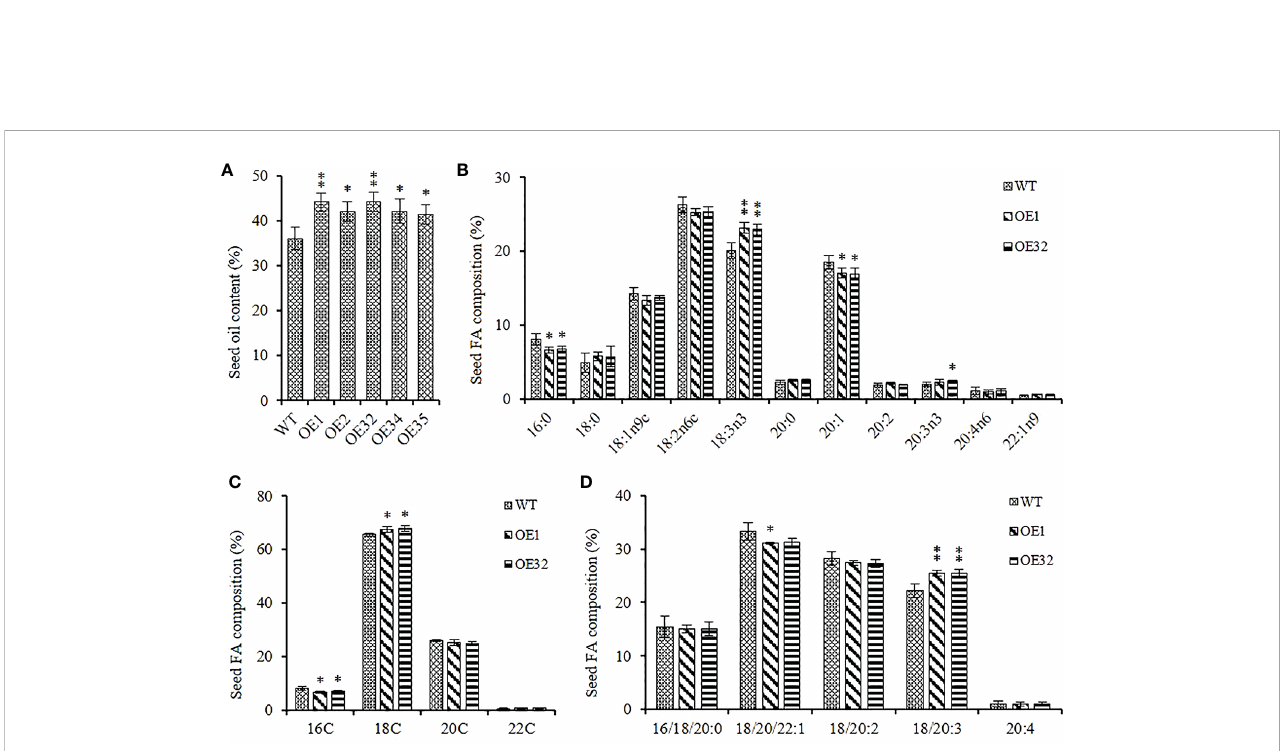
FIGURE 6 Seed oil content and composition of homozygous AhGPAT9 overexpression lines. (A) Oil content in seeds from wild type (WT) and AhGPAT9 overexpression lines (OE). (B) FA composition of seed TAG. (C) 16C/18C/20C/22C FAs content of seed TAG. (D) Saturated and unsaturated FAs content of seed TAG. Asterisks indicate signi fi cant differences from the WT: *P < 0.05; **P < 0.01 (Student ’ s t-test). Data are shown as means ± standard deviation (n =